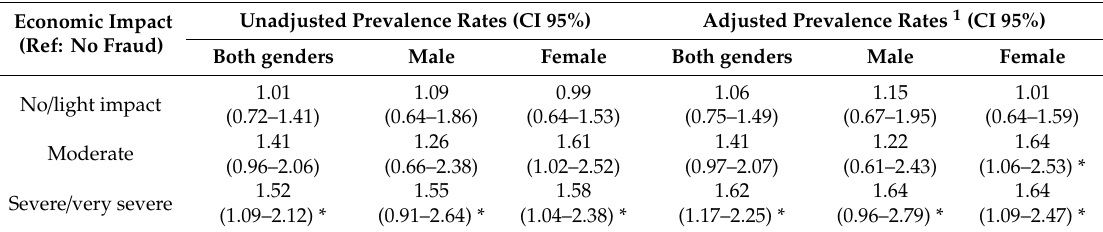
Table 5. Prevalence rates ratio of mental health problems by economic